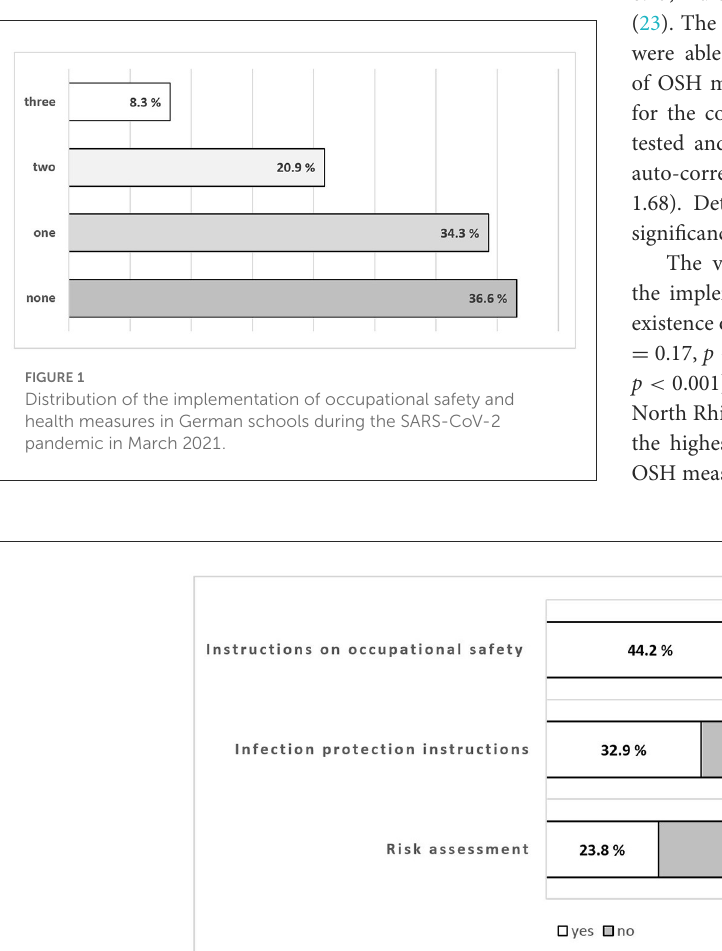
FrontiersinPublicHealth